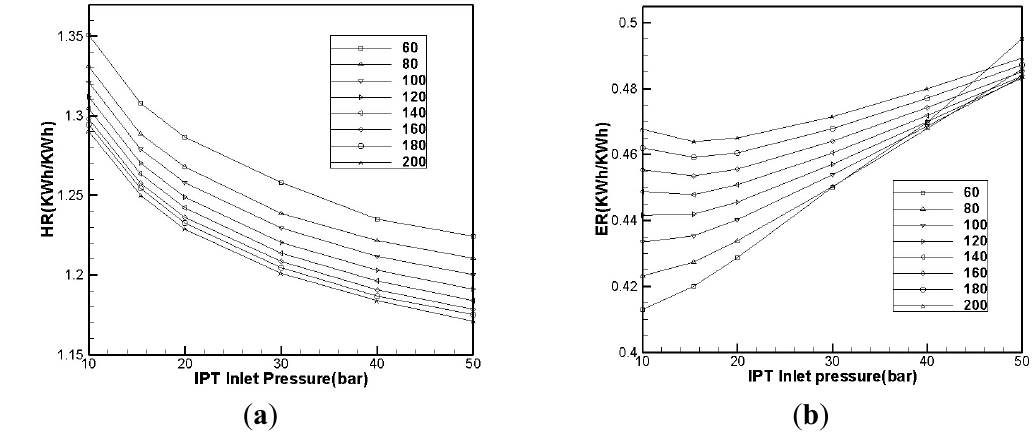
Figure 12. Effect of IPT inlet pressure on ( a ) HR and ( b ) ER given different HPT inlet